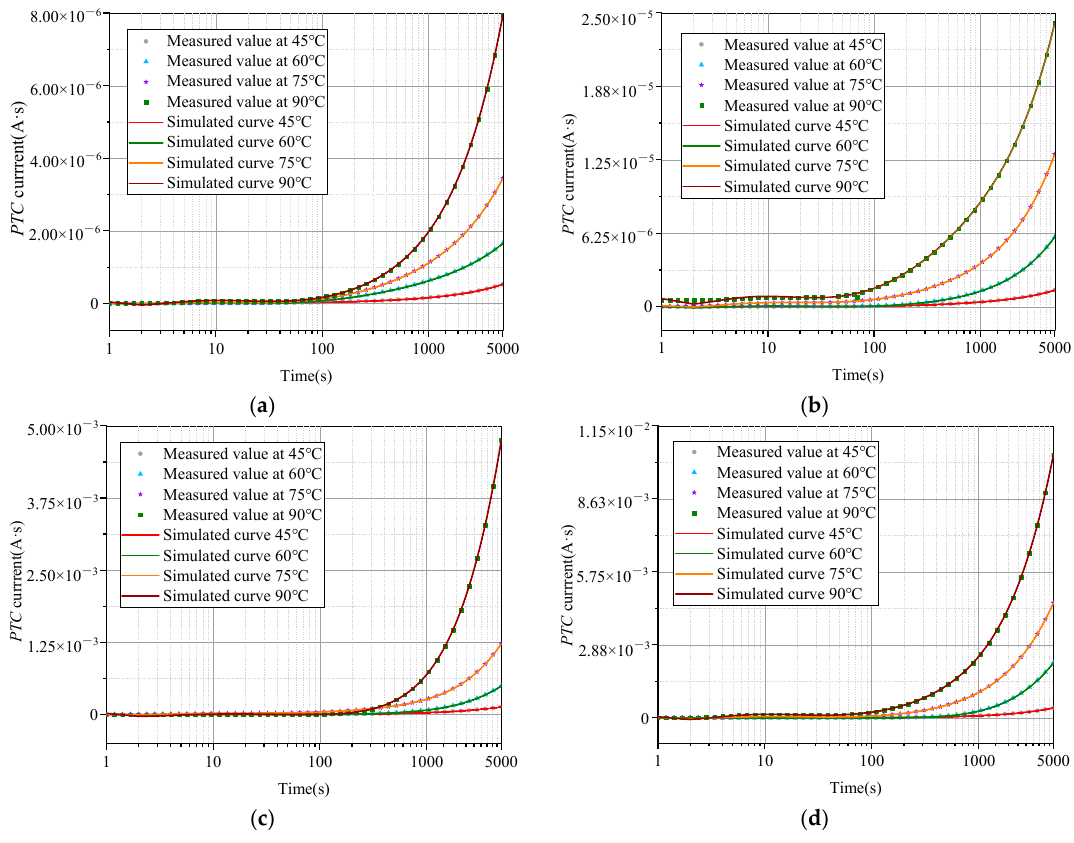
Figure 3. Fitting results of polarization time-varying current ( PTC) curves with different moisture contents and test temperatures. ( a ) mc % = 1.13%, ( b ) mc % = 1.94%, ( c ) mc % = 2.82%, ( d ) mc % = 3.36%.